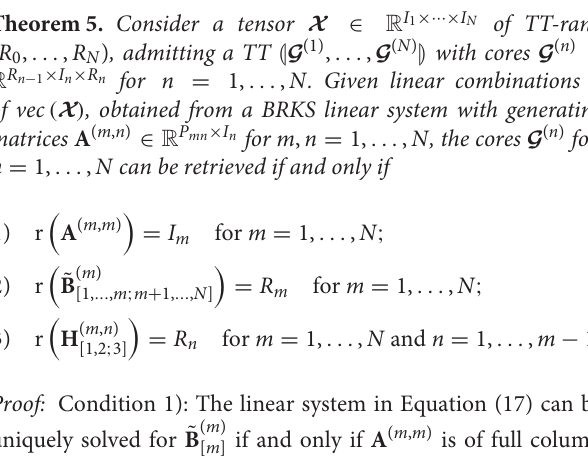
Algorithm 1 and 2 , Algorithm 3 also accommodates both the RTD- and CS-setting.